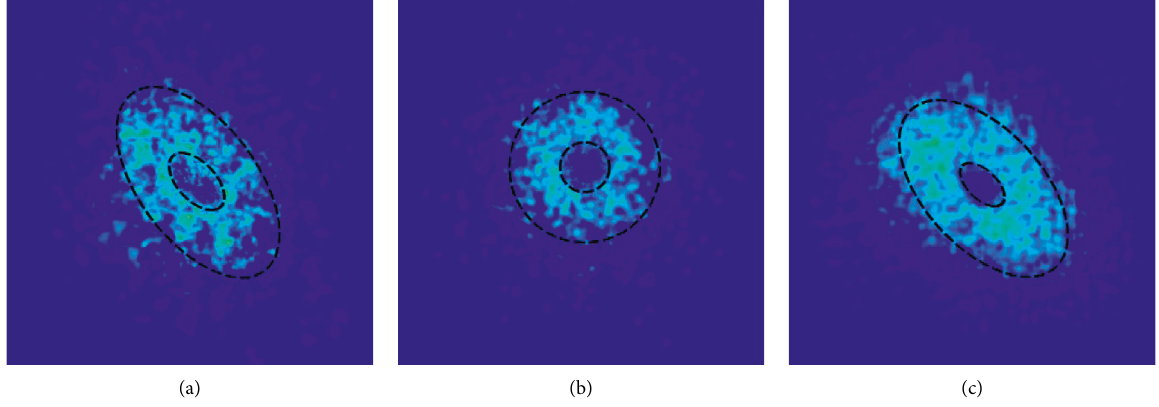
Figure 4: FFT data for energy dissipation in (a) ZrCuAl, (b) ZrCuAlNb, and (c) ZrCuAlNi.